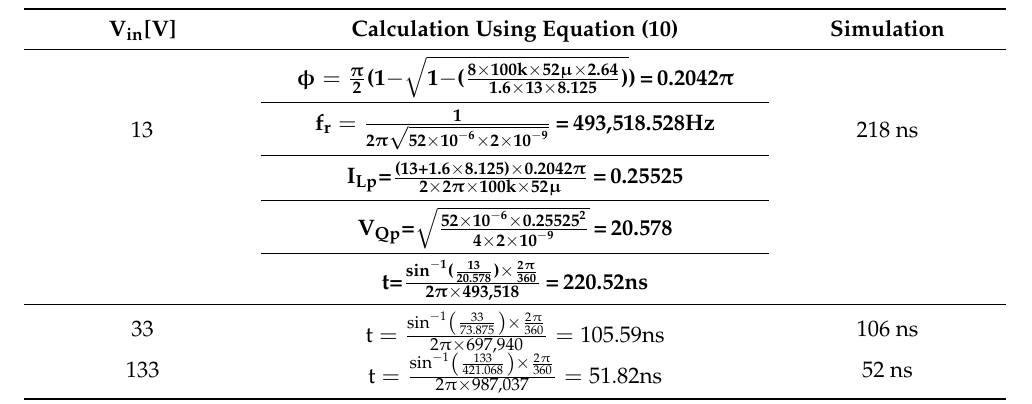
Table 3. Delay time calculated using equation.